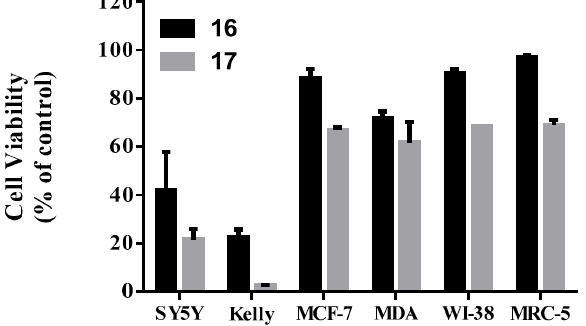
Figure 6. Comparative toxicity of compounds 29 and 30 against the tested cell lines at 10 µM after 72 h exposure. Cell viability values are quoted as a percentage of the negative control.